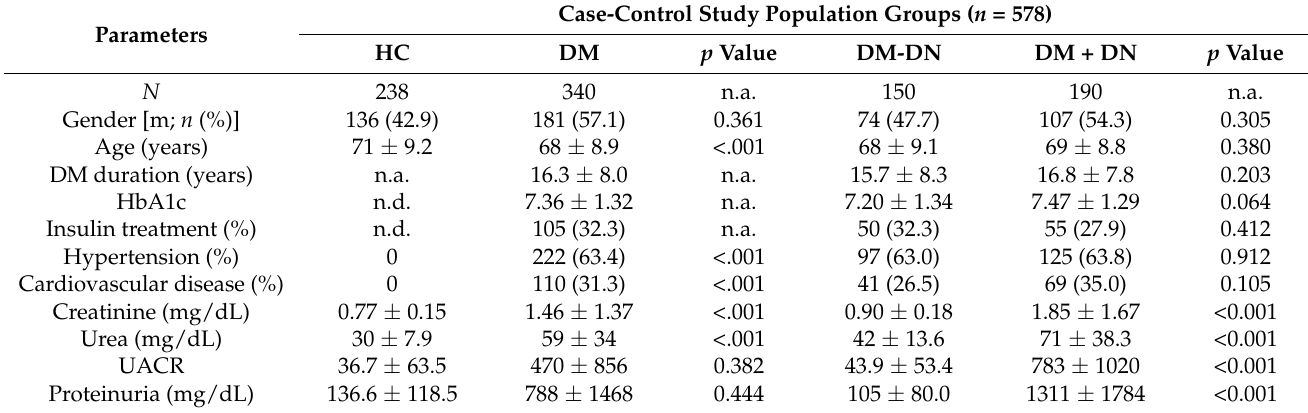
Table 1. Clinical characteristics of the participants in the association